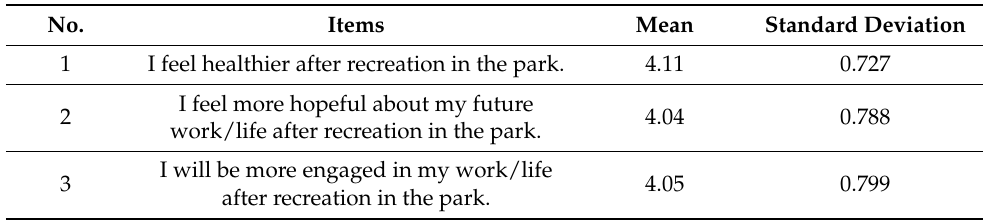
Table 8. Evaluation of leisure benefits.